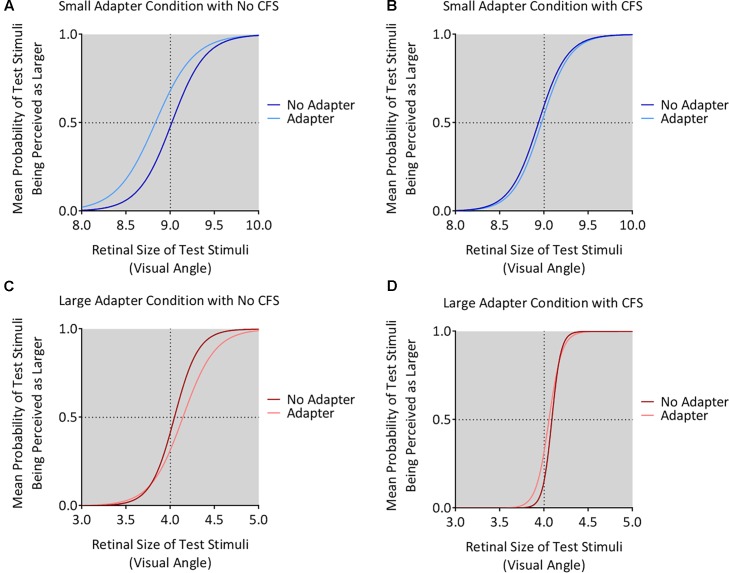
Mean psychometric function curves for all conditions. The figure shows the mean psychometric curves for participants in the small adapter condition during the No CFS
(A) and CFS
(B) conditions. The figure also shows the mean psychometric curves for participants in the large adapter condition during the No CFS
(C) and CFS
(D) conditions. Dark curves correspond to the adapter absent condition while light curves correspond to the adapter present condition. The x-axes correspond to the test stimulus size in visual angle (1° corresponding to 1 cm in physical size) while the y-axes correspond to the probability (P) that the test stimulus appeared larger than the reference stimulus. The dashed horizontal lines denote the actual size of the reference stimulus while the dashed vertical lines denote the points of subjective estimation (PSE) defined as P = 0.5. The PSE represents how large the target stimulus needed to be for the participant to judge this stimulus as having the same apparent size as the reference stimulus. Conceptually, this means higher PSE values for when the test stimulus was perceived smaller.